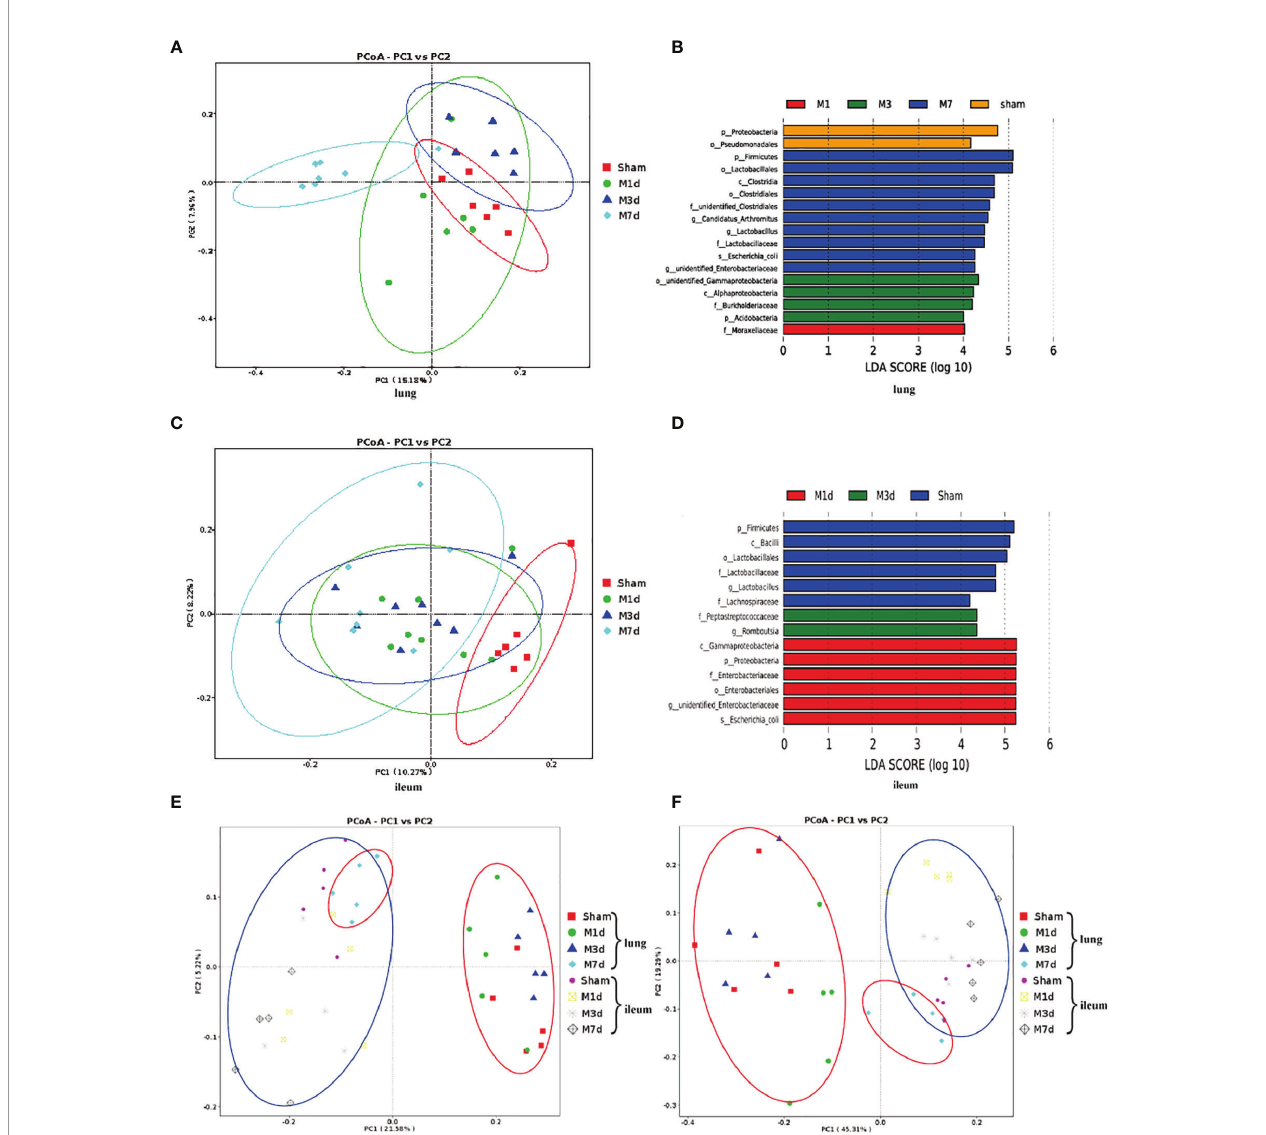
FIGURE 6 | Differences in the lung and ileum microbiota of the ICH model at 1 d, 3 d and 7 d. (A) The microbial communities in lung samples in the ICH model at different time points were compared using a PCoA plot based on a weighted UniFrac distance metric. (B) The LEfSe method was used to analyze the differences in bacterial fl ora among groups and to identify the speci fi c bacterial fl ora in lung tissue from each group (LDA score > 4). (C) The microbial communities in ileum samples at 1 d, 3 d and 7 d following ICH were compared using a PCoA plot based on a weighted UniFrac distance metric. (D) The distribution of LDA values in ileum tissue displayed as a histogram, with an LDA value of >4 indicating a statistically signi fi cance among groups. (E, F) We next used unweighted and weighted UniFrac analyses to explore the relationship between lung microbiota samples and ileum samples collected at 1, 3 and 7 d following ICH (red ovals, lung tissue samples; blue ovals, ileum tissue